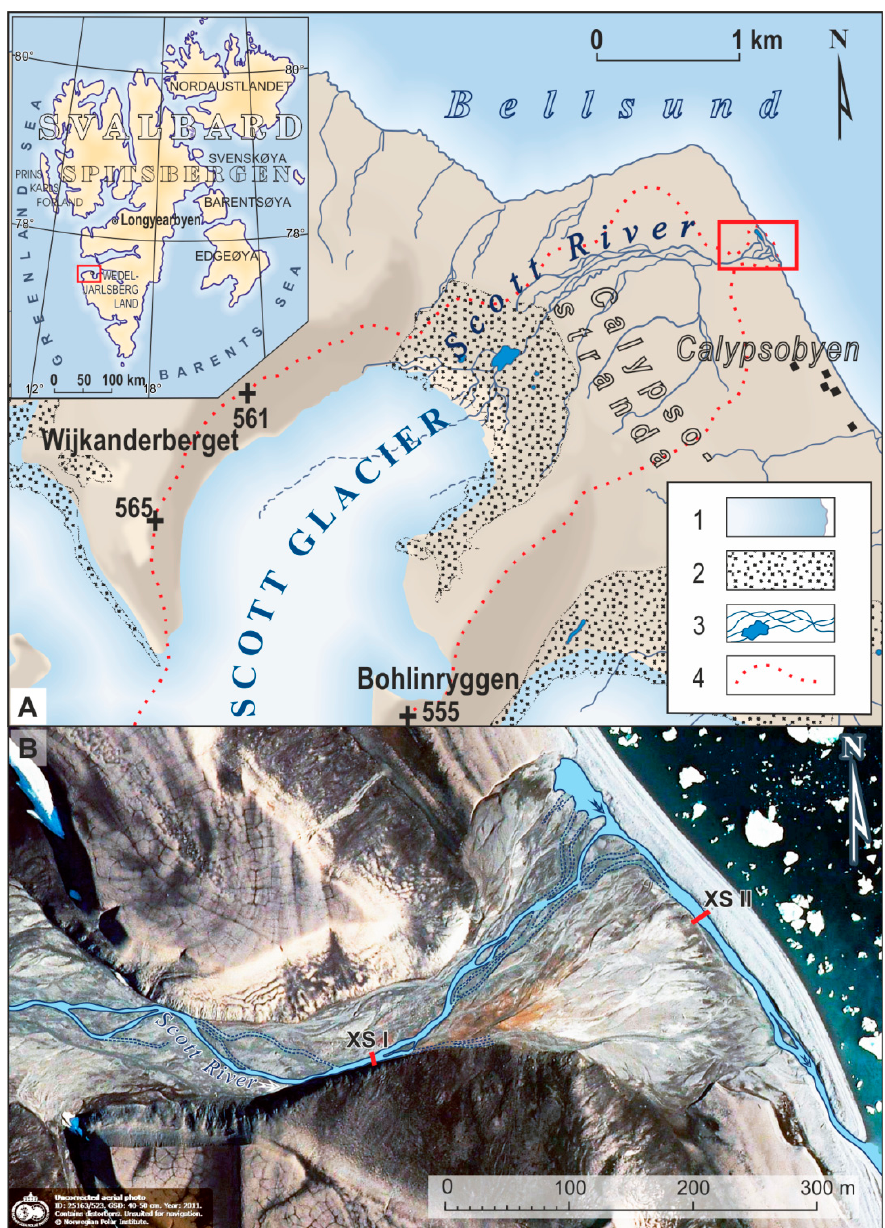
Figure 1. Location of the study site: ( A ) on the Svalbard Archipelago and NW part of Wedel-Jarlsberg Land: 1. valley glaciers, 2. glacial accumulation zones/terminoglacial zones, 3. rivers and water bodies, 4. catchment border; ( B ) on the lower part of the Scott River catchment with marked measurement cross sections XS I and XS II (background aerial photo by NPI (2011; Available online: http://toposvalbard.npolar.no/flyfoto.html?id=25163523; accessed on 9 March 2018).